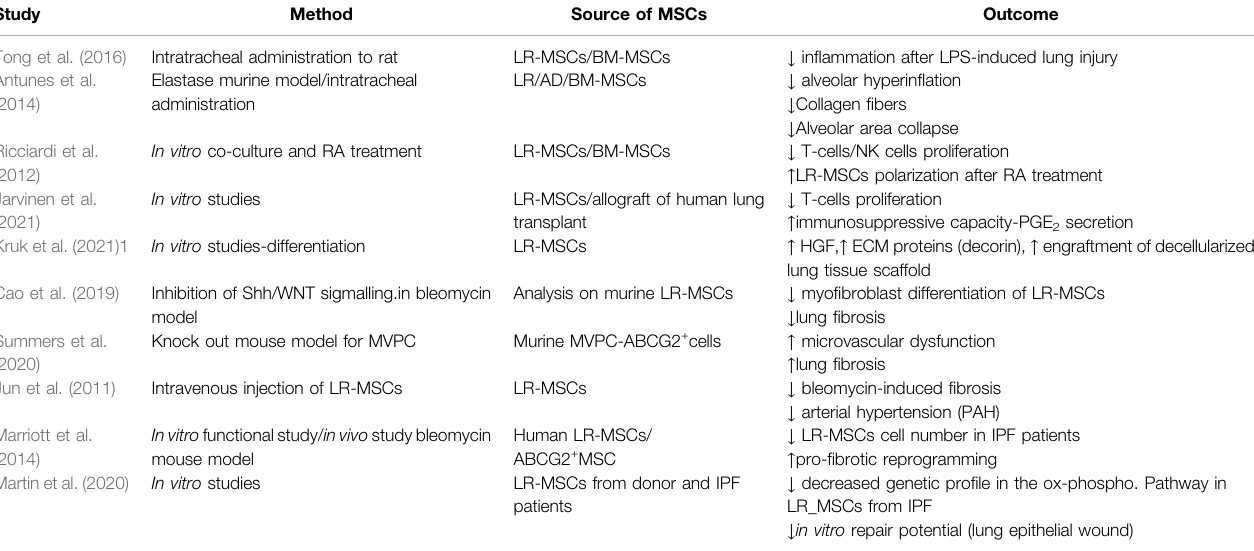
TABLE 1 | In vitro and in vivo studies involving LR-MSCs in lung homeostasis, injury and